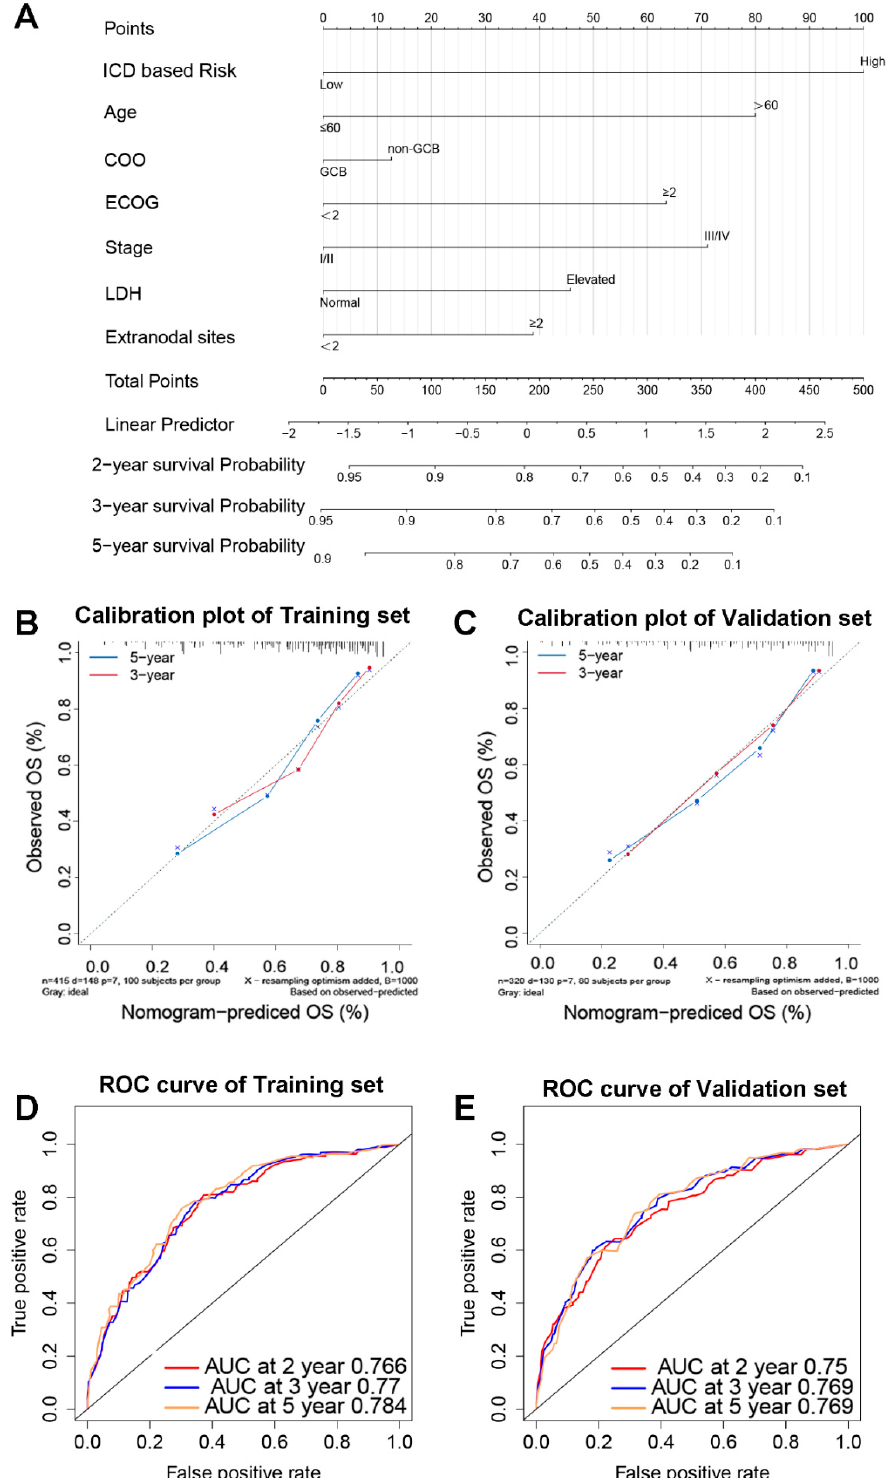
Figure 7. An ICD-related gene signature-based prediction model. The nomogram prediction model for DLBCL patients’ OS ( A ). Calibration graphs of the training set’s 3-year and 5-year survival probabilities ( B ) and the validation set’s ( C ). The 2-year, 3-year, and 5-year OS in the training set ( D ) and validation set ( E ) are predicted by time-dependent ROC curves. Abbreviations: COO, cell of origin; GCB, germinal center B cells; ECOG, Eastern Cooperative Oncology Group; LDH, lactate dehydrogenase; OS, overall survival; AUC, area under the